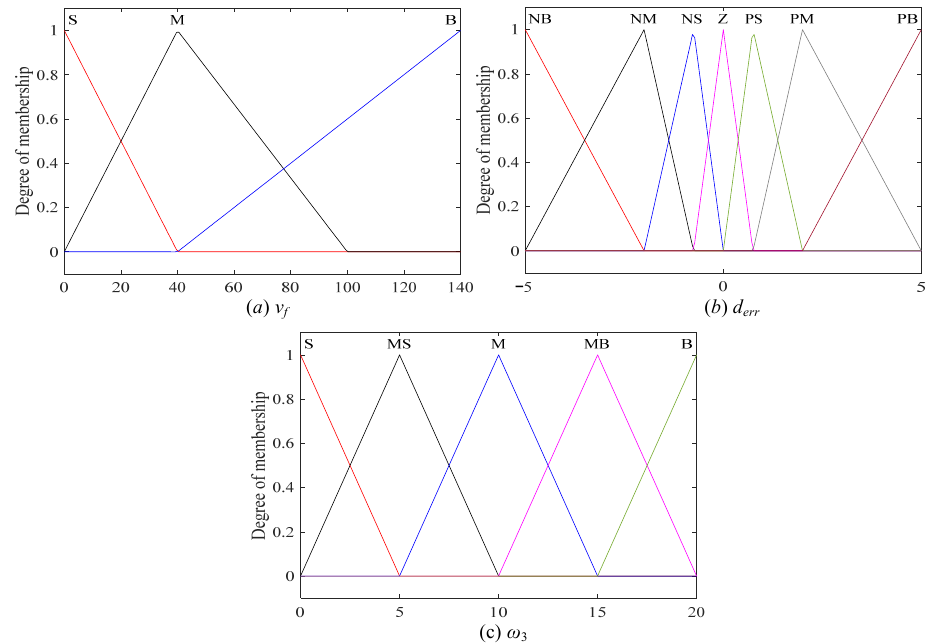
Figure 7. Membership function: ( a ) v f , ( b ) d err , ( c ) ω 3 .